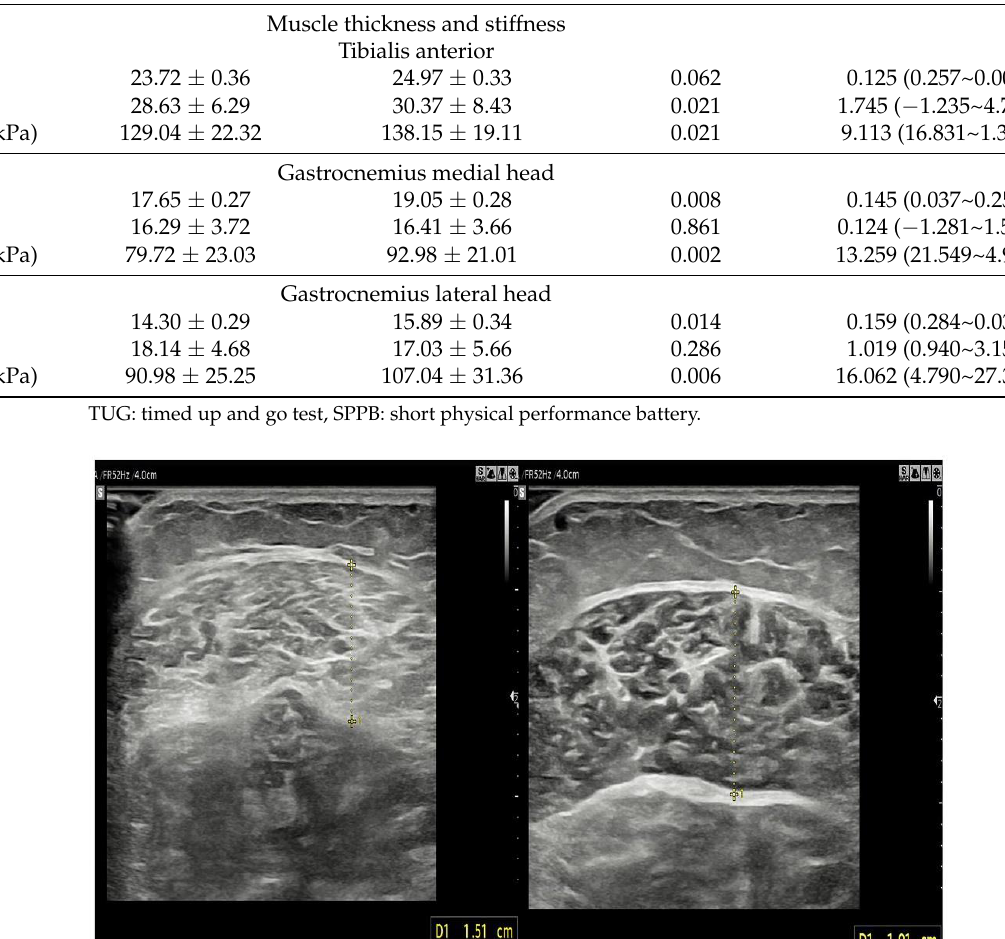
Figure 6. Comparison of contractive stiffness of gastrocnemius medialis between faller ( left ) and non-faller ( right ). 3.2. Correlation between Physical Function and Muscle Thickness and Stiffness in Fallers Table 3 summarizes the correlation between the balance ability and muscle thickness and elasticity of fallers. Gamed thickness was correlated with the FRT ( p = 0.017, r = 0.375) and gait speed ( p = 0.038, r = 0.329). Whereas Gamed rest elasticity was correlated with the SPPB ( p = 0.034, r = 0.337), Gamed contraction elasticity was correlated with the gait speed ( p = 0.045, r = 0.319) and SPPB ( p = 0.035, r = 0.334). However, TA and Galat showed no significant correlations with any of the above parameters. Table 3. Pearson correlations between balance ability muscle thickness and stiffness in the fallers.